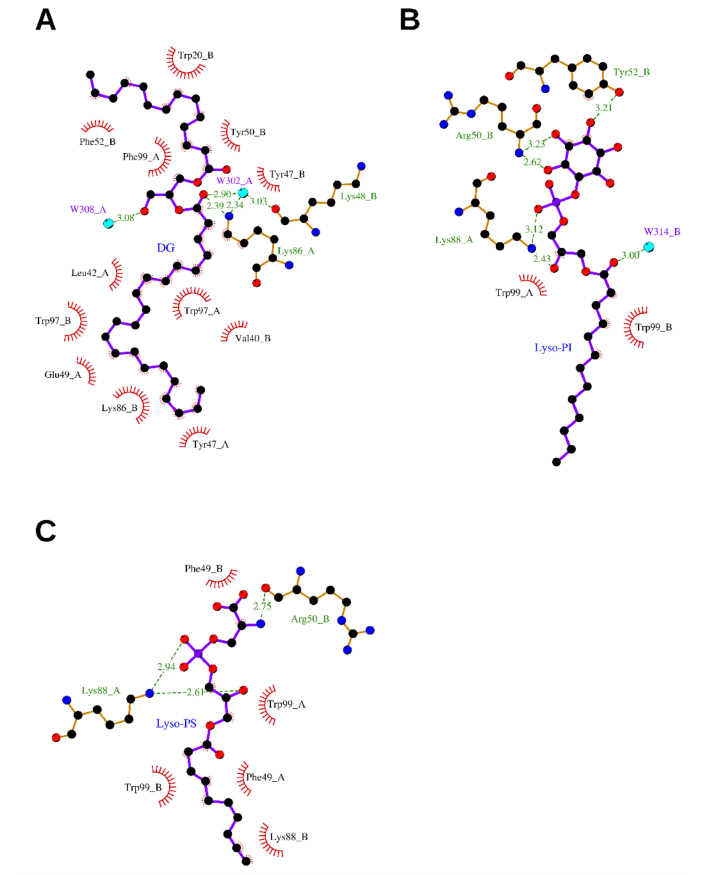
Figure 3. Binding sites of mNGF/hNGF/cNGF complexed with DG ( A ), Lyso-PI ( B ), Lyso-PS ( C ), respectively. The ligands and the protein side chains are shown in ball-and-stick representation, with the ligand bonds colored in purple. Hydrogen bonds are shown as green dotted lines, while the spoked arcs represent protein residues making nonbonded (hydrophobic) contacts with the ligand. The 2D ligand–protein interaction diagrams have been produced with LigPlot+